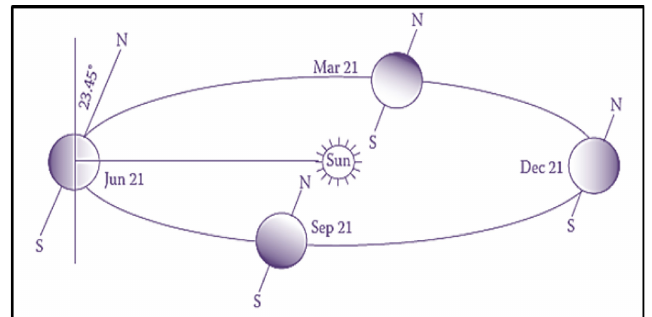
Figure 5. Path of the earth and the declination at various times of the year